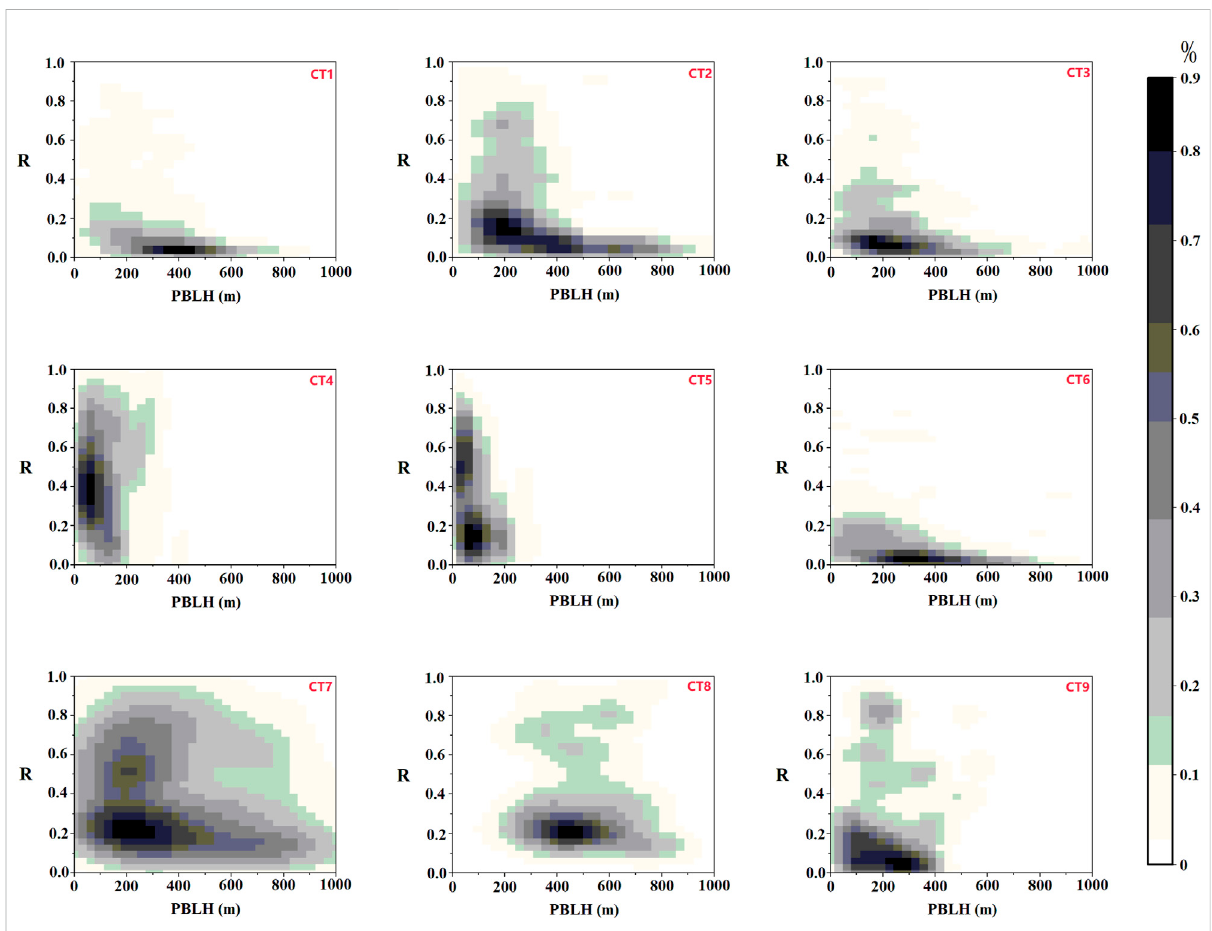
FIGURE 11 Scatter plot of the two-dimensional kernel density distribution of the recirculation index R and PBLH under the nine CTs in the CZT